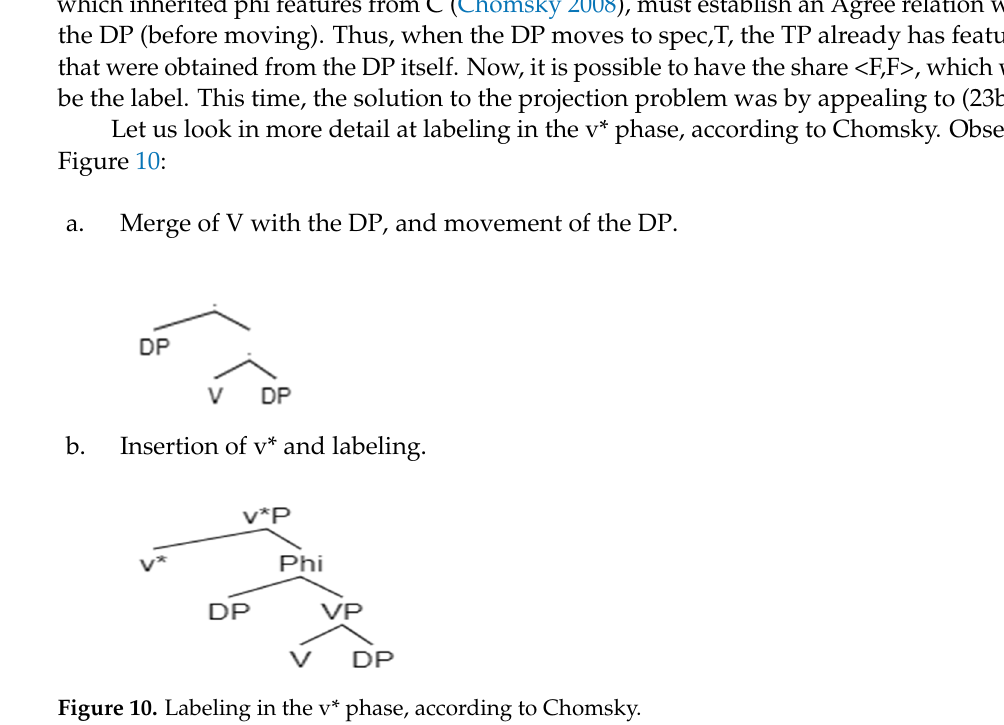
Figure 10. Labeling in the v* phase, according to Chomsky.